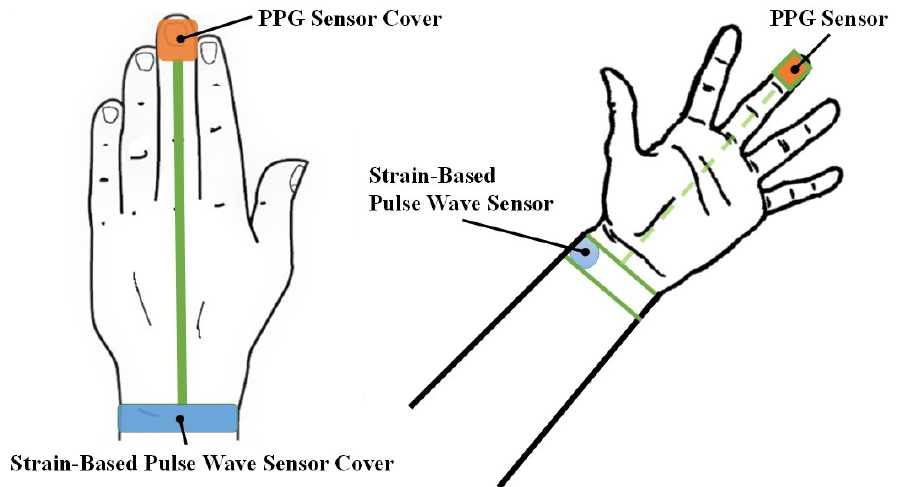
Figure 1. Schematic the proposed continuous blood pressure (BP) monitoring be listed as: ( a ) Description of what is contained in the first panel. ( b ) Description of what is contained in the second panel. Figures should be placed in the main text near to the first time they are cited. A caption on a single line should be centered.